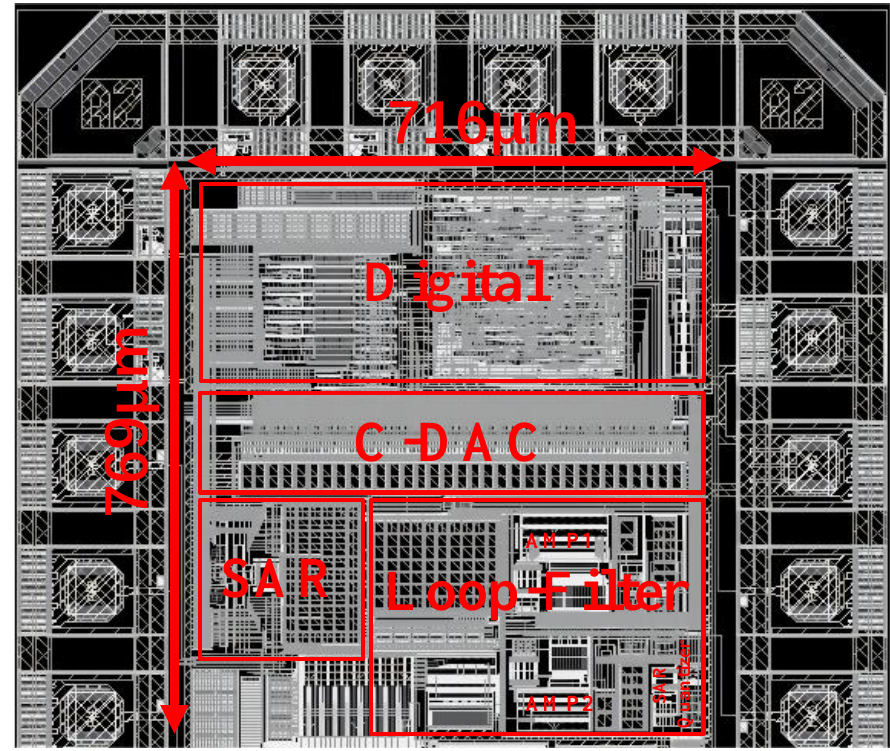
Figure 13. Layout of the proposed